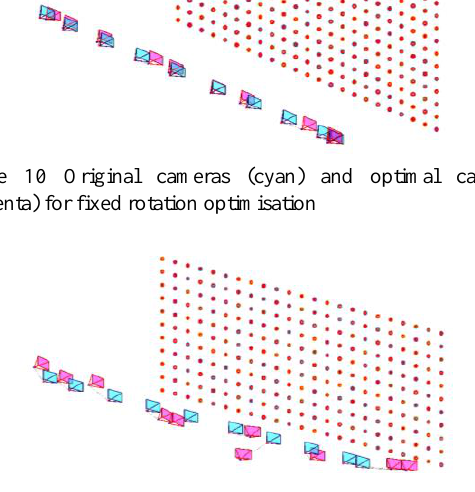
Figure 11 Optimization results including rotations. The